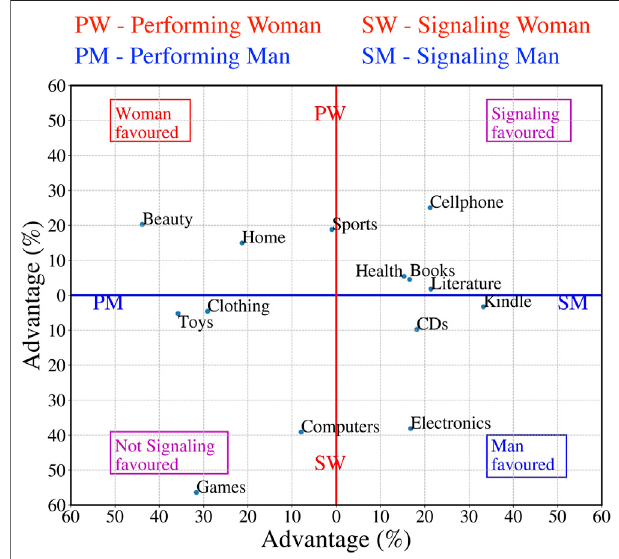
FIGURE 7 | Summary of the context-speci fi c gender effects. We combineandsummarizetheresultsof Figures6C,D toclassifyeachcategory into - 1 ) signaling man favoured, 2 ) signaling woman favoured, 3 ) signaling favoured and 4 ) performance favoured. The x -axis from left to right denote performingtosignaling men (PM-SM) while y -axis from toptobottom denotes performing to signaling women (PW - SW). Each point in the fi gure denotesacategoryanditspositionisdeterminedbyitscorrespondingvaluein Figures 6C,D . Notably, categories like Electronics, CDs or Kindle seem to favour signaling men. Similarly Beauty or Home seem to favor signaling women. Moreover, categories such as Cellphone, Health or Books favour gender signals from user names while Games, Computers and Toy favour